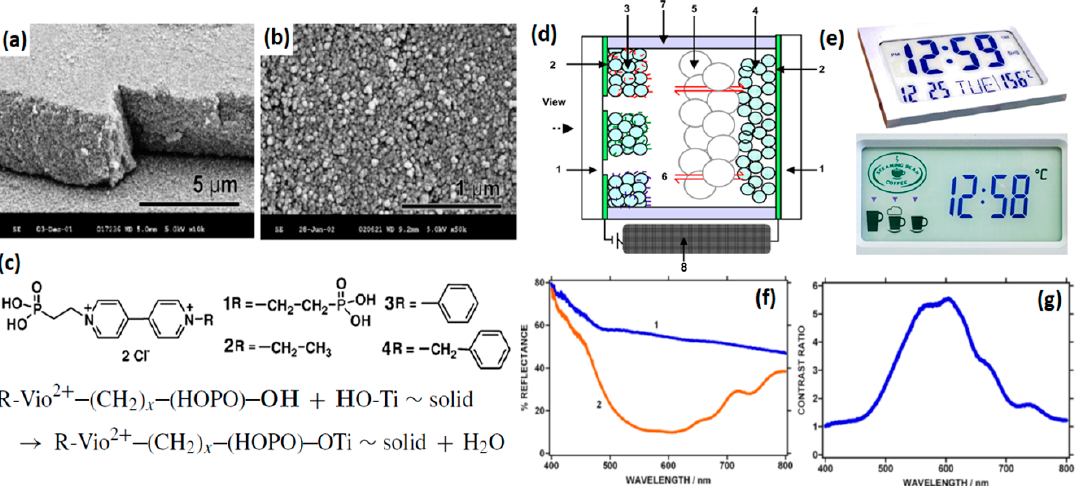
Figure 12. ( a , b ) Scanning electron micrograph (SEM) images of nanocrystalline TiO 2 layers of 4 μ m thickness. ( c ) Examples of viologen molecules functionalized with phosphonic acid groups for attachment onto TiO 2 surface through formation of phosphonic acid ester. ( d ) Cross-section structure of a Nanochromics TM display. 1: Transparent glass, 2: conducting glass coating, 3: viologen/TiO 2 , 4: SnO 2 :Sb counter electrode, 5: white reflector TiO 2 layer, 6: electrolyte, 7: sealant, 8: electric driving system. ( e ) Examples of Nanochromics TM displays. ( f ) Reflectance spectra of bleached 1 and colored 2 state vs. wavelength (electrode area 4 cm 2 for both viologen/TiO 2 (6 μ m) and SnO 2 :Sb; applied voltages: 0 and − 1.3 V, respectively.) ( g ) Contrast ratio vs. wavelength at − 1.3 V. Readapted with